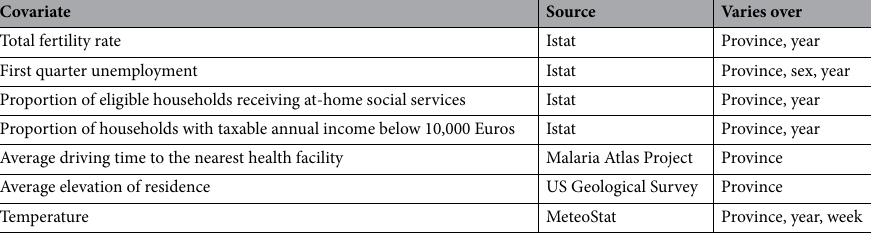
Table 2. Covariates used to estimate baseline mortality by age group, sex, province, and week across Italy from January 2015 through August 2020. The source and space-time resolution of each covariate is